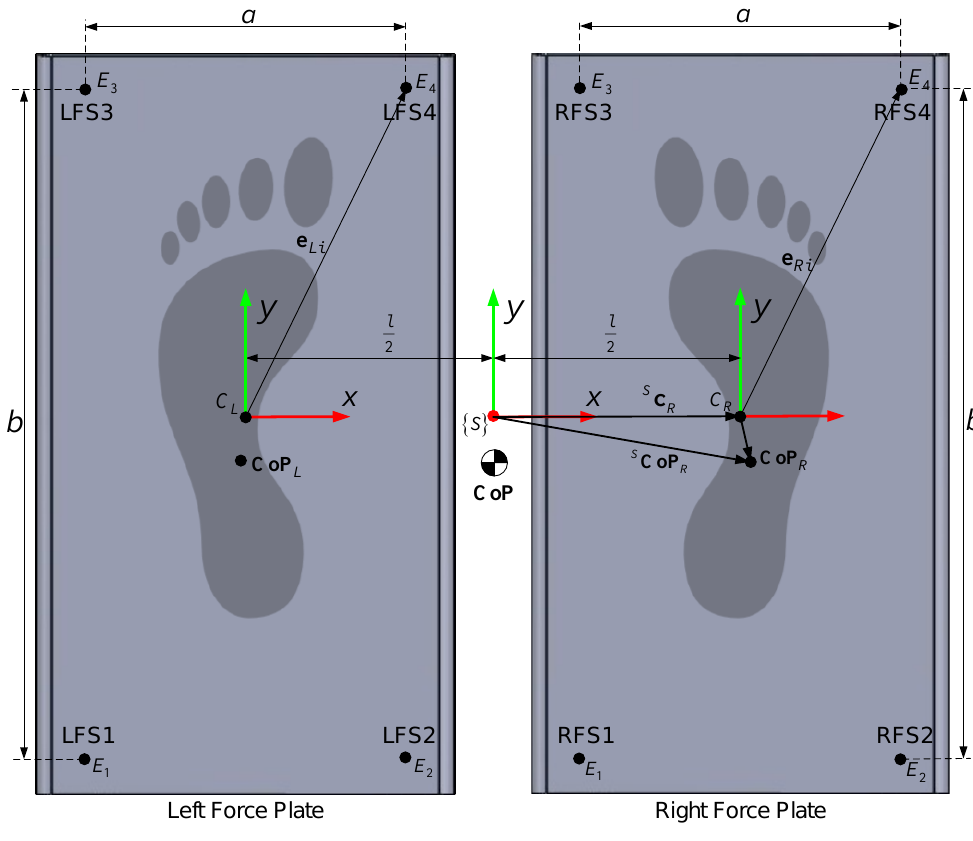
Figure 7. Left and right leg force plate